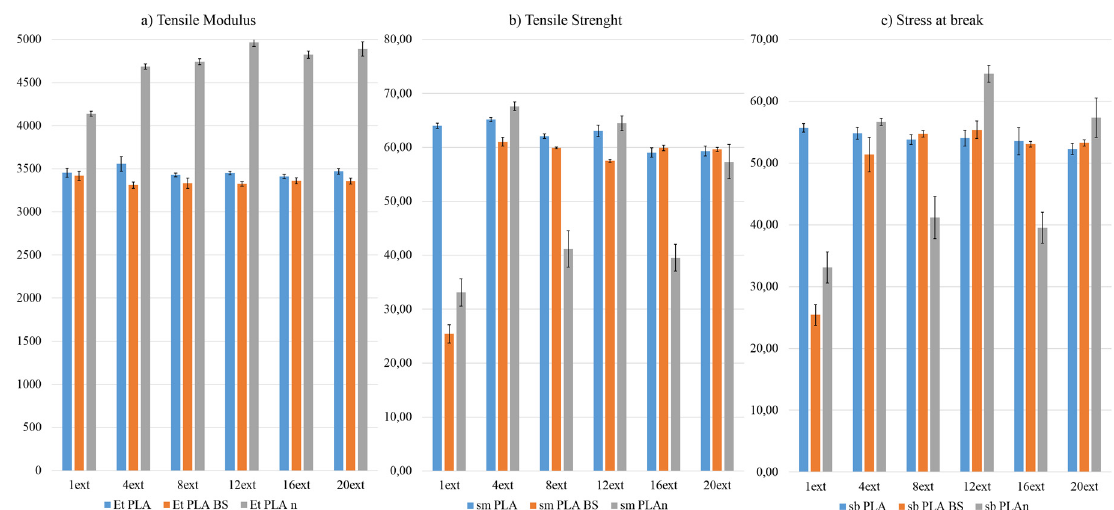
Figure 2. Graphical Representation of the ( a ) Tensile Modulus (E t ); ( b ) Tensile Strength ( σ t ) and ( c ) Stress at break ( σ b ) of the three formulations by each extrusion.